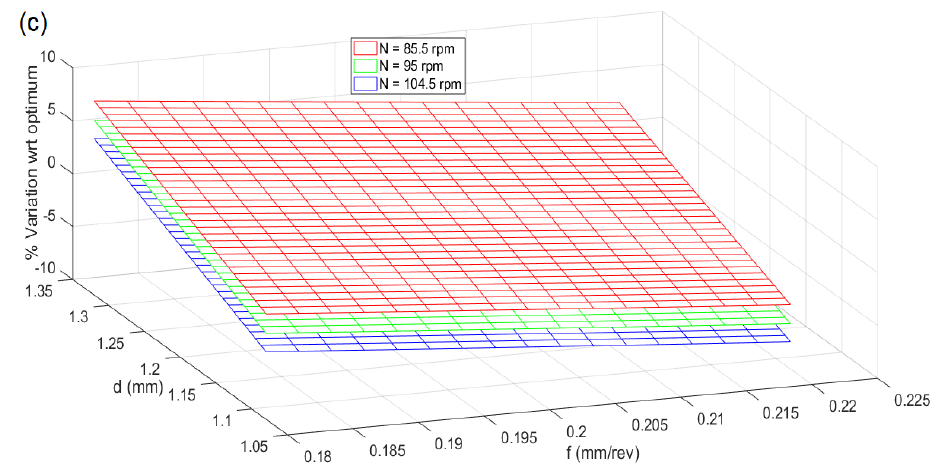
Figure 10. Robustness of the CHP solutions in terms of % variation with respect to optimum when ( a ) spindle speed and feed rate are varied ± 10% from their respective optimum values, ( b ) spindle speed and depth of cut are varied ± 10% from their individual optimum value ( c ) depth of cut and feed rate are varied ± 10% from their respective optimum value.